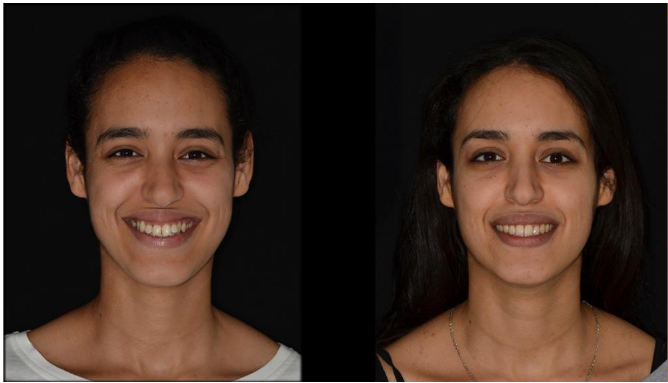
Figure 6. Pre and post treatment smile.